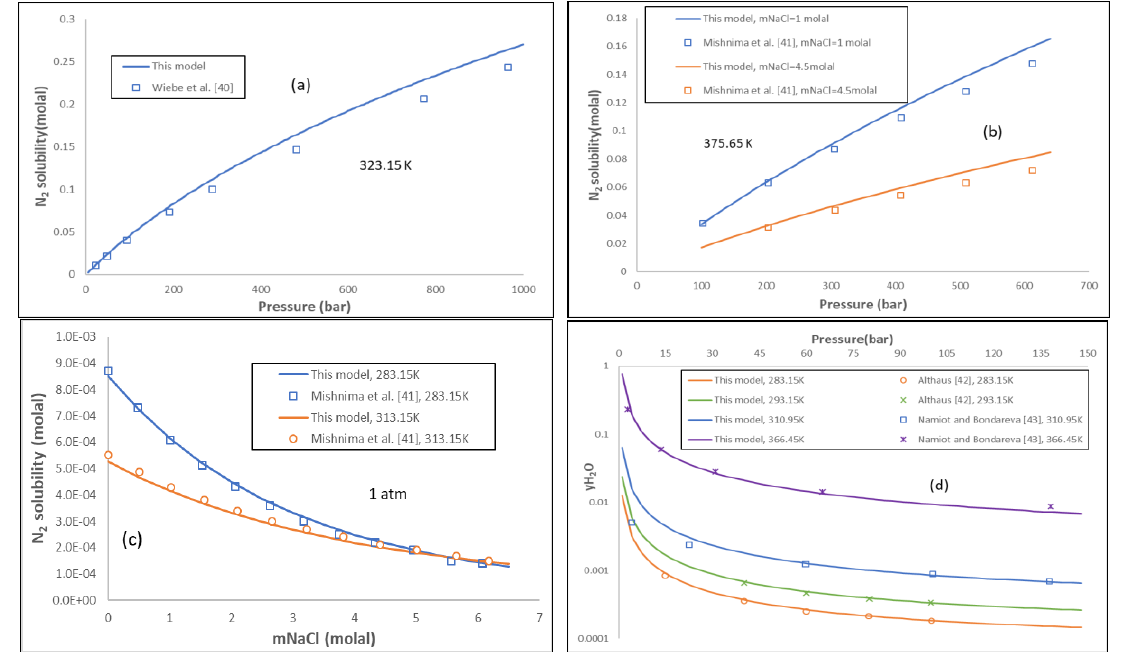
Figure 2. N 2 -brine mutual solubility obtained from experimental data [40–43] (dots) and the results calculated by the model at various values of temperature, pressure and salinity. ( a ) N 2 solubility in water. ( b ) N 2 solubility in NaCl solutions varying with pressure. ( c ) N 2 solubility in NaCl solutions varying with NaCl molality at 1 atm. ( d ) H 2 O solubility in N 2 -rich phase.